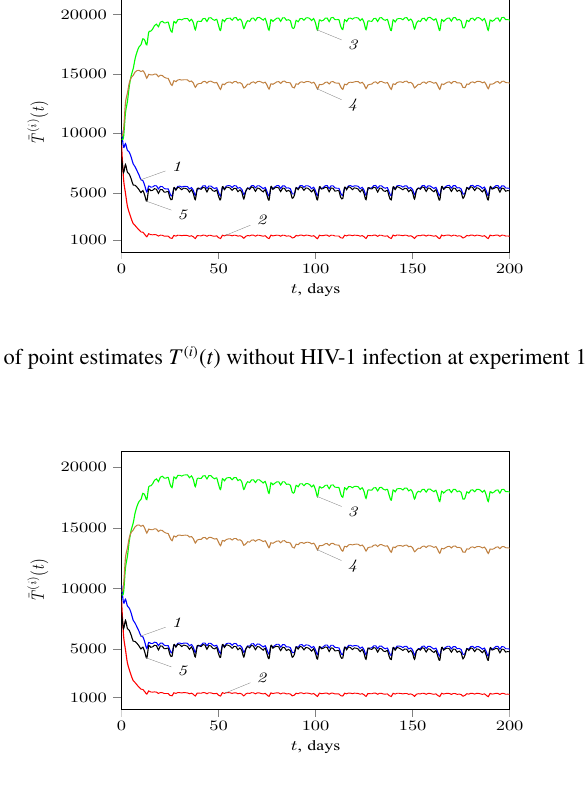
1 Figure 4. Dynamics of point estimates T ( i ) ( t ) with HIV-1 infection at experiment